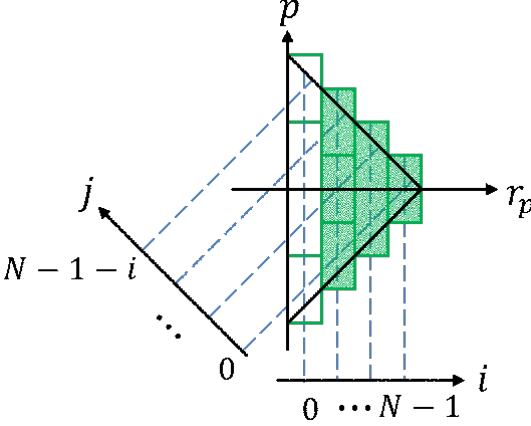
Figure 11. Illustrating the region corresponding to r > 0 in ( p , r p )